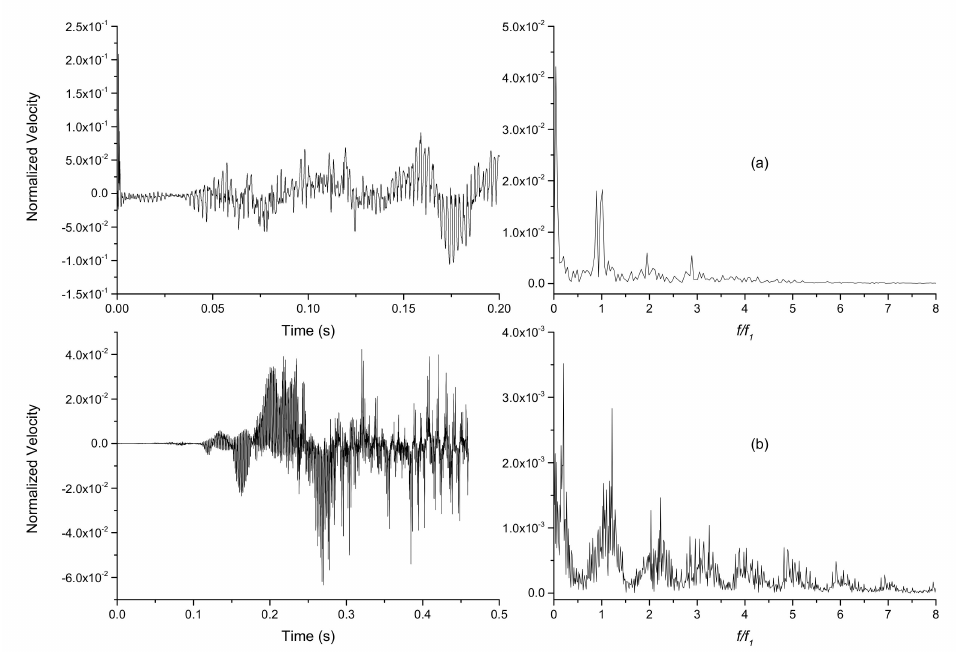
Figure 10. The z-velocity at the center of the branch entrance. ( a ) Case 1; ( b ) Case